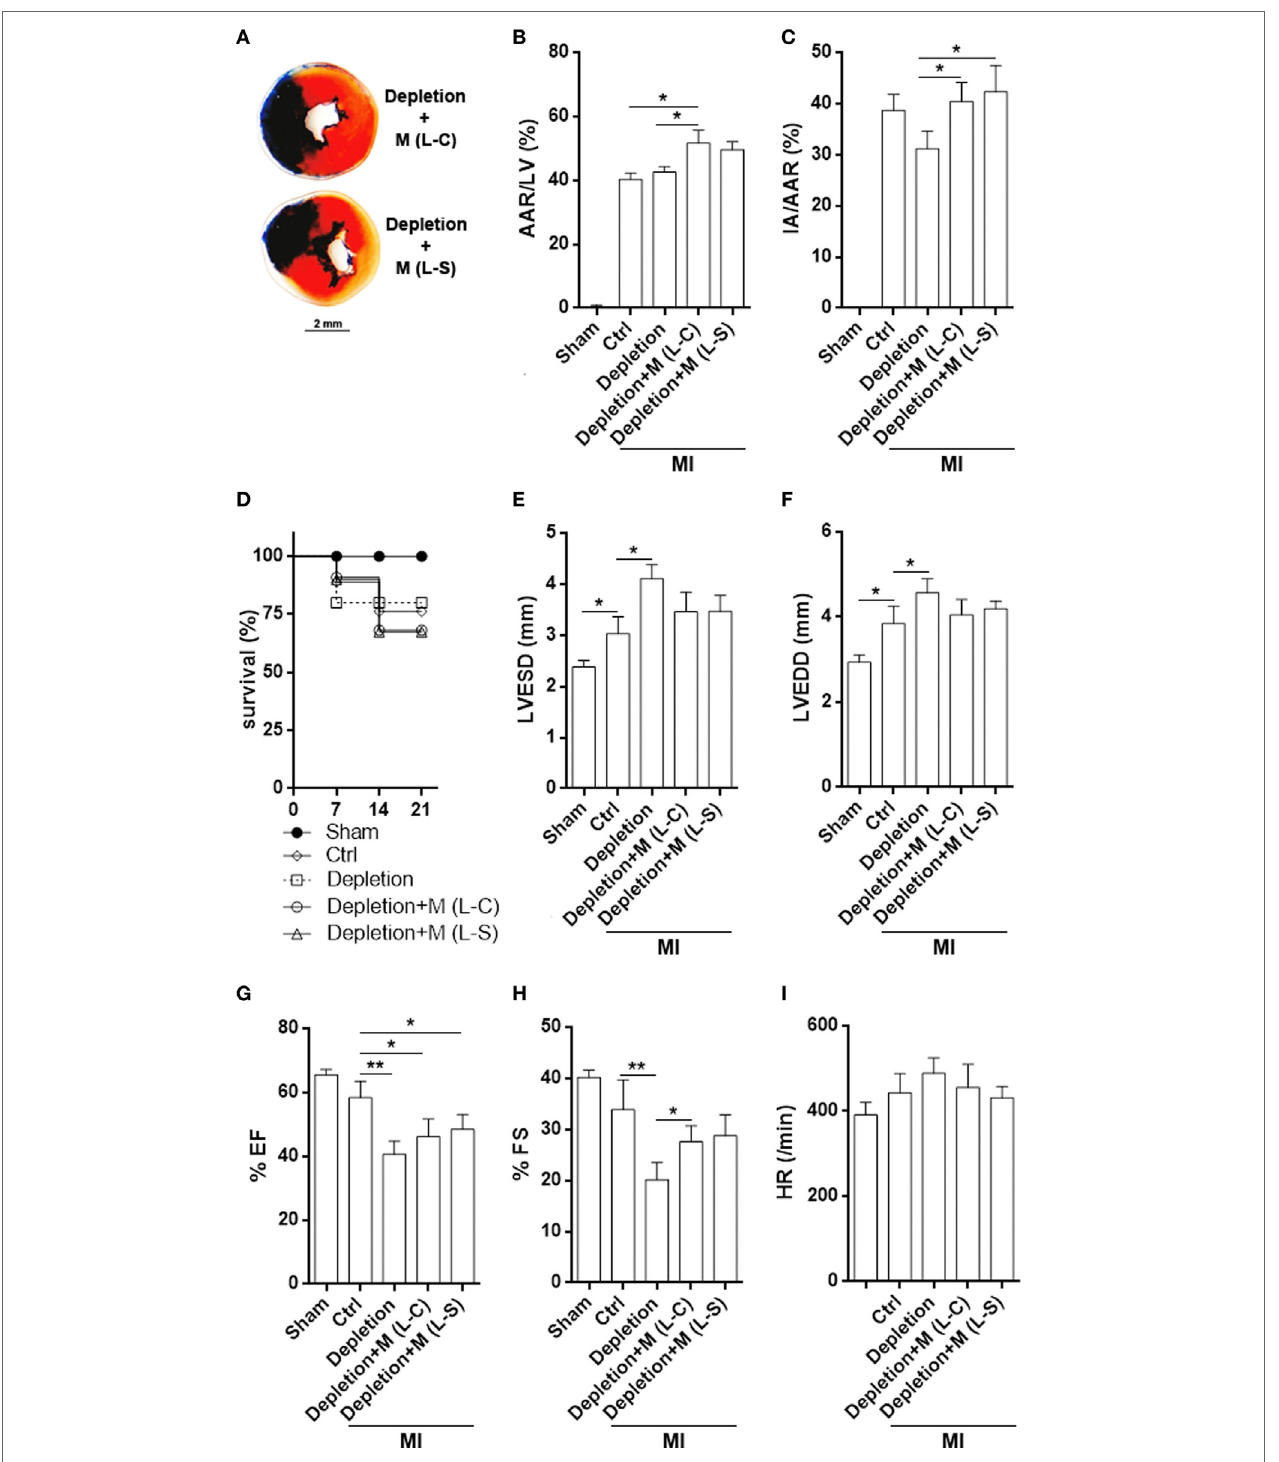
FigUre 7 | Infarct size and left ventricle function after myocardial infarction (MI). (a) Representative triphenyltetrazolium chloride staining image. (B,c) Measurement of area at risk and infarct area. Ctrl: un-pretreated mice. Depletion: Clophosome ® injection. Depletion + M (L-C): Clophosome ® injection followed by transfer of M1 macrophages transduced with control lentivirus. Depletion + M (L-S): Clophosome ® injection followed by transfer of M1 macrophages transduced with SESN2 lentiviral activation particles. AAR/LV: area at risk volume relative to left ventricle volume. IA/AAR: infarct area relative to area at risk. N = 6 per group. (D) Mouse survival after MI. (e–i) Evaluation of left ventricle end-systolic diameter (LVESD), LVEDD, FS, ejection fraction (EF), and heart rate by echocardiography 2 weeks after MI. N = 5–6 per group. * p < 0.05; ** p <